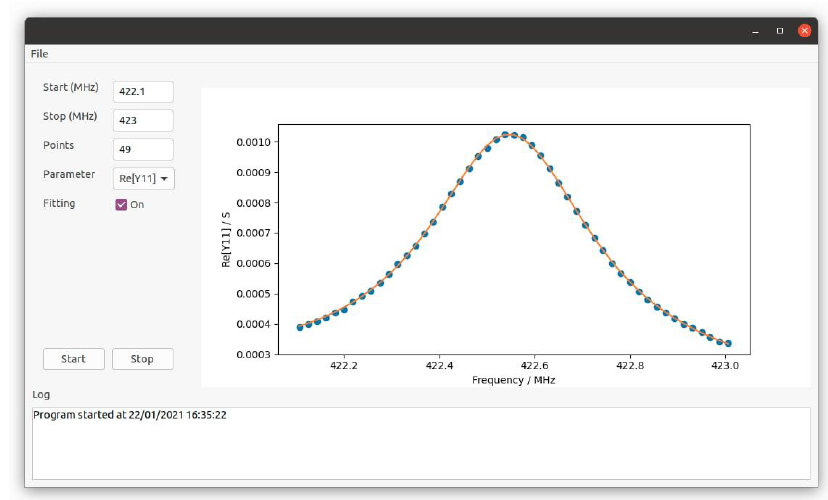
Figure 3. Illustration of the GUI developed in Python environment.